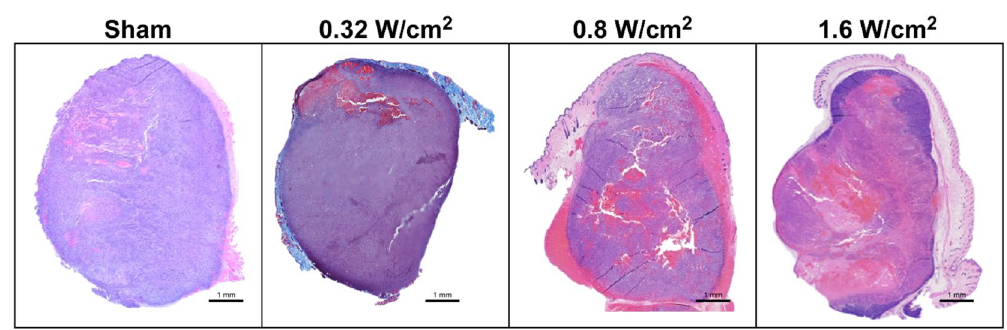
Figure 3. Histologic evaluation of murine HCC tumors treated with US. H&E-stained images taken from sham-treated and US-treated (I SATA = 0.32, 0.8, or 1.6 W/cm 2 ) tumors collected after treatment. Pink color represents hemorrhagic area. Scale bar 1